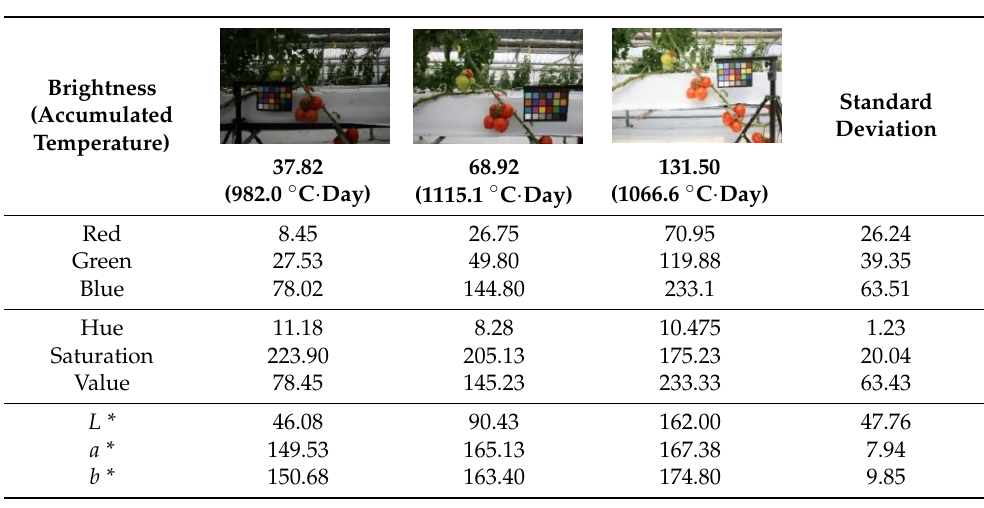
Table 2. Comparisons of the color models.